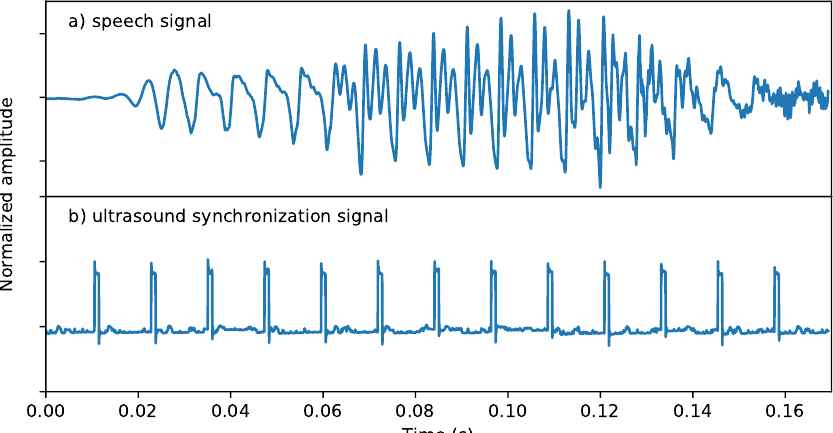
Figure 2. Ultrasound synchronization signal: the rising edge of the pulses indicates the capture time of ultrasound